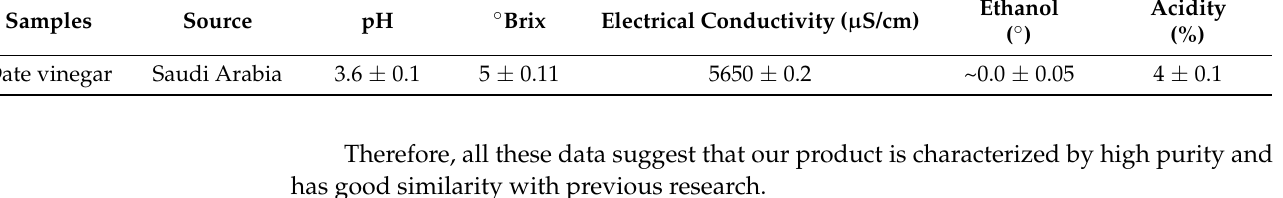
Table 4. Results of physico-chemical analyzes of date vinegar.